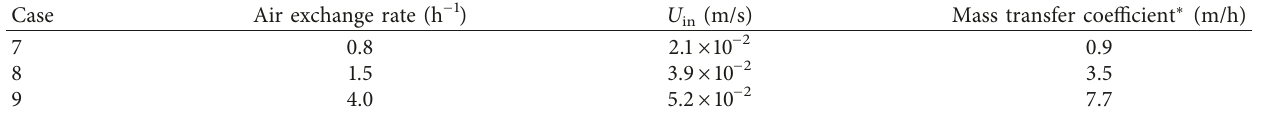
Table 4: A list of computational fluid dynamics (CFD) analysis cases (temperature � 28 ° C).